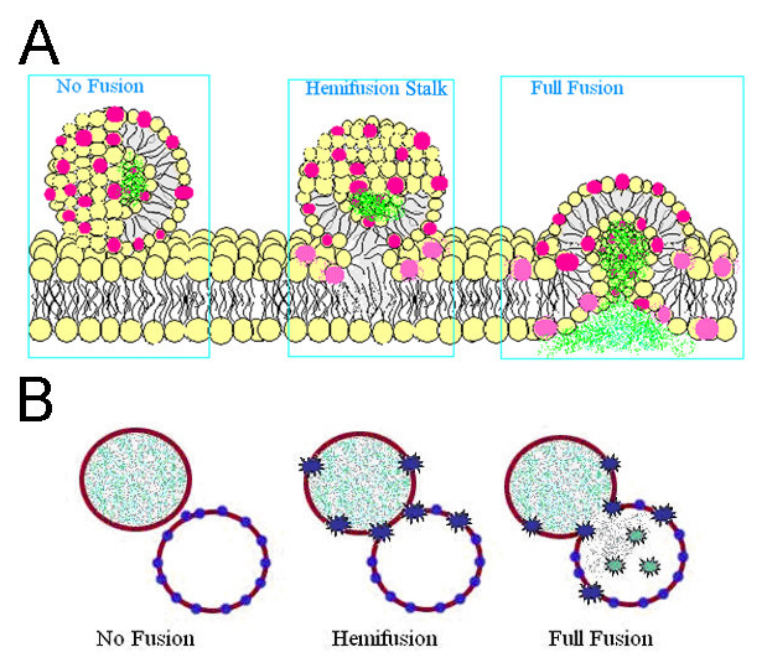
FIGURE 2. Fluorescent lipid-like dyes incorporated into a virus membrane can report on lipid mixing occurring during hemifusion, but detection of content mixing is required to confirm pore formation and full fusion. (A) Fusion of a vesicle with membrane and content dye to an unlabeled planar bilayer. (B) Fusion of a membrane-labeled vesicle to a content-labeled